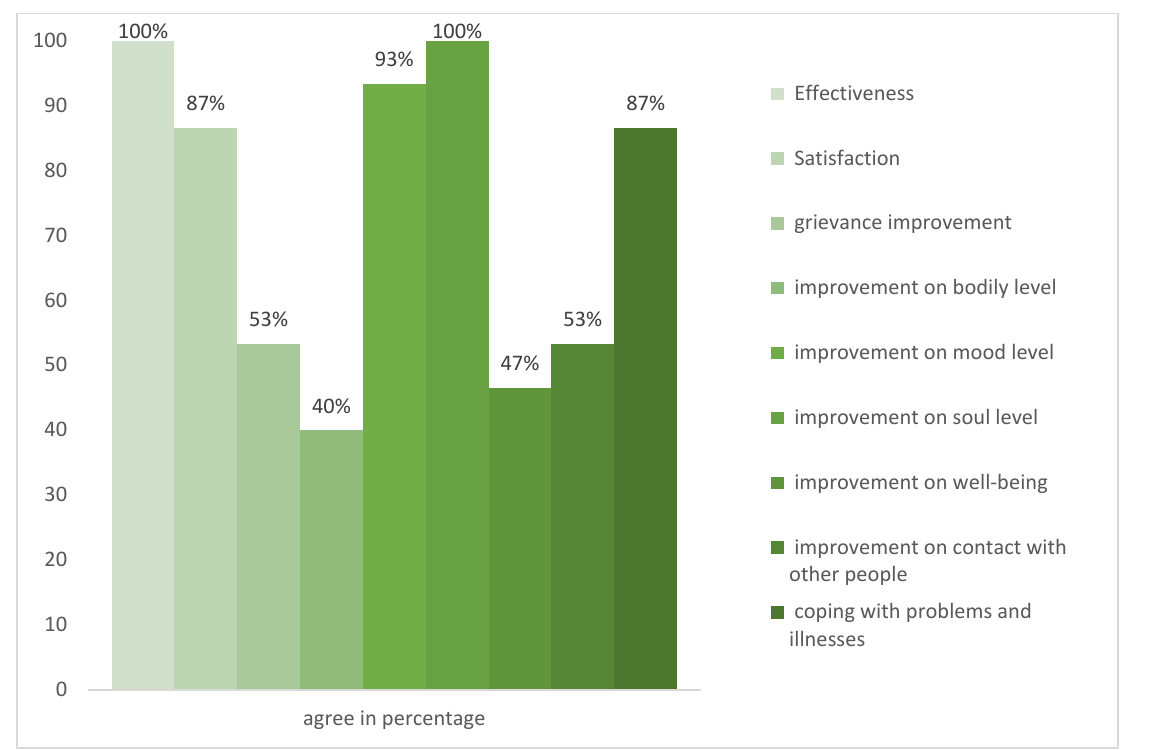
Figure 5. Experienced effectiveness, satisfaction, and improvements from nature-based therapy based on the self-rated post-testing questionnaire.